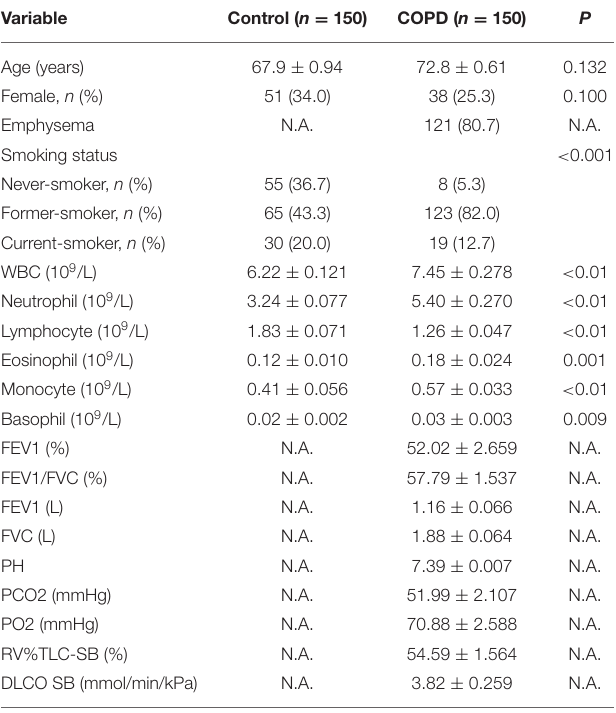
TABLE 1 | Demographic information and clinical